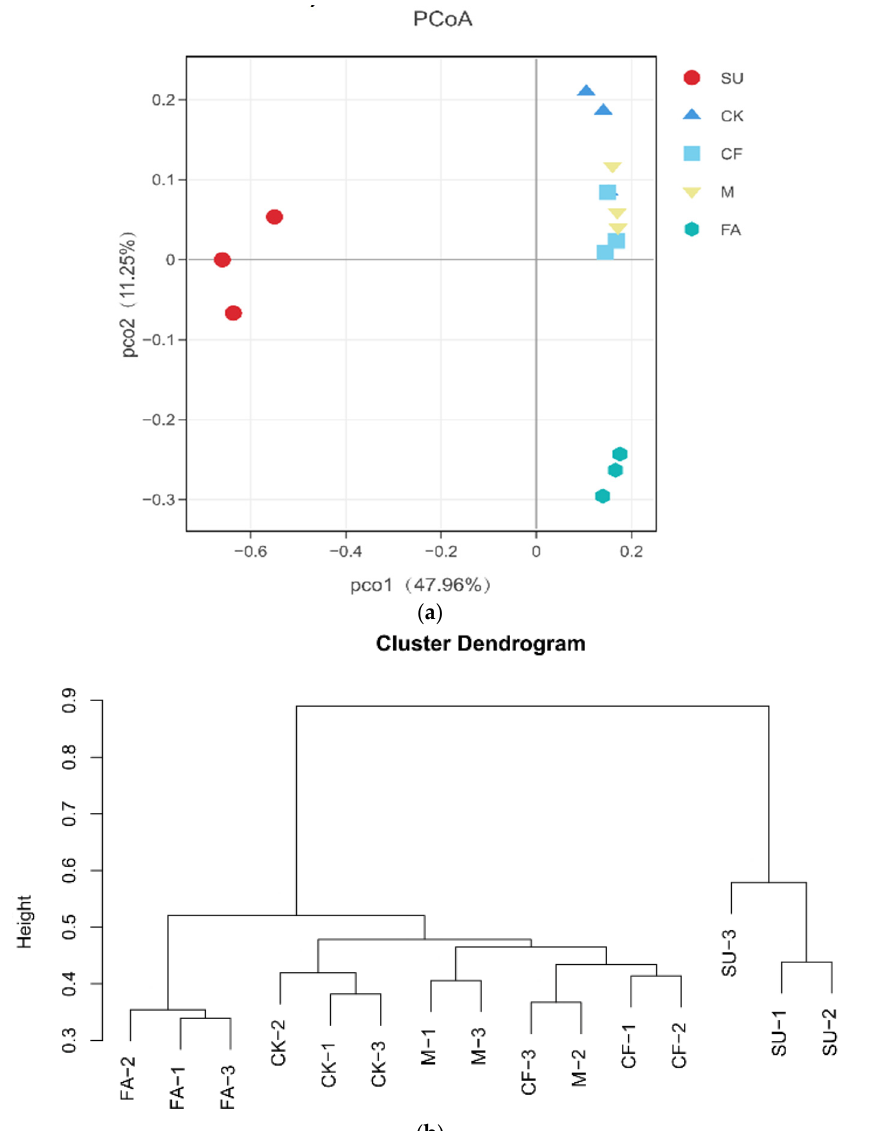
Figure 3. ( a ) Principal coordinate analysis (PCoA) based on unweighted UniFrac distances of soil bacterial communities sampled from different treatments; ( b ) similarity trees based on Bray–Curtis distance indices were calculated by OTUs at a distance of 3% using the hierarchical clustering analysis of bacterial communities for soil samples. CK: reclaimed soil sampled in no-fertilizer treatment; CF: reclaimed soil sampled in chemical fertilizer treatment; M: reclaimed soil sampled in manure treatment. SU: subsided soil sampled in an adjacent site; FA: soil sampled in another adjacent